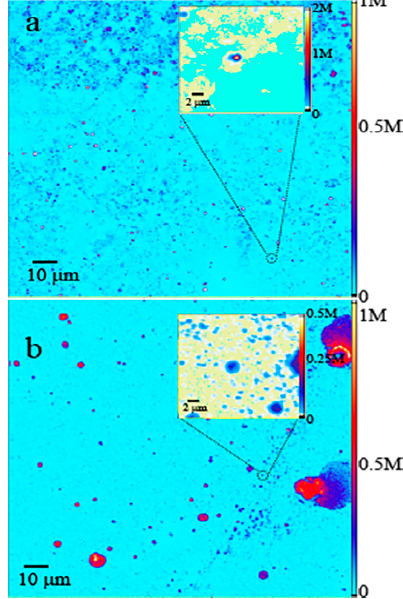
Figure 2. ( a ) Two-dimensional confocal fluorescence maps (100 × 100 μ m 2 ) for ( a ) commercial and ( b ) ball-milled MgO NPs, excited with 200 μ W power. The insets show fine scans of 10 × 10 μ m 2 dimensions. The fluorescence intensity detected by the SPAD is expressed in counts per second (counts/s).